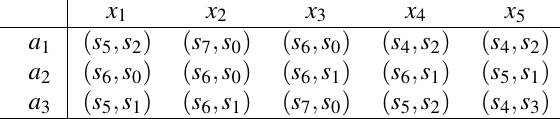
Table 8. Decision matrix R